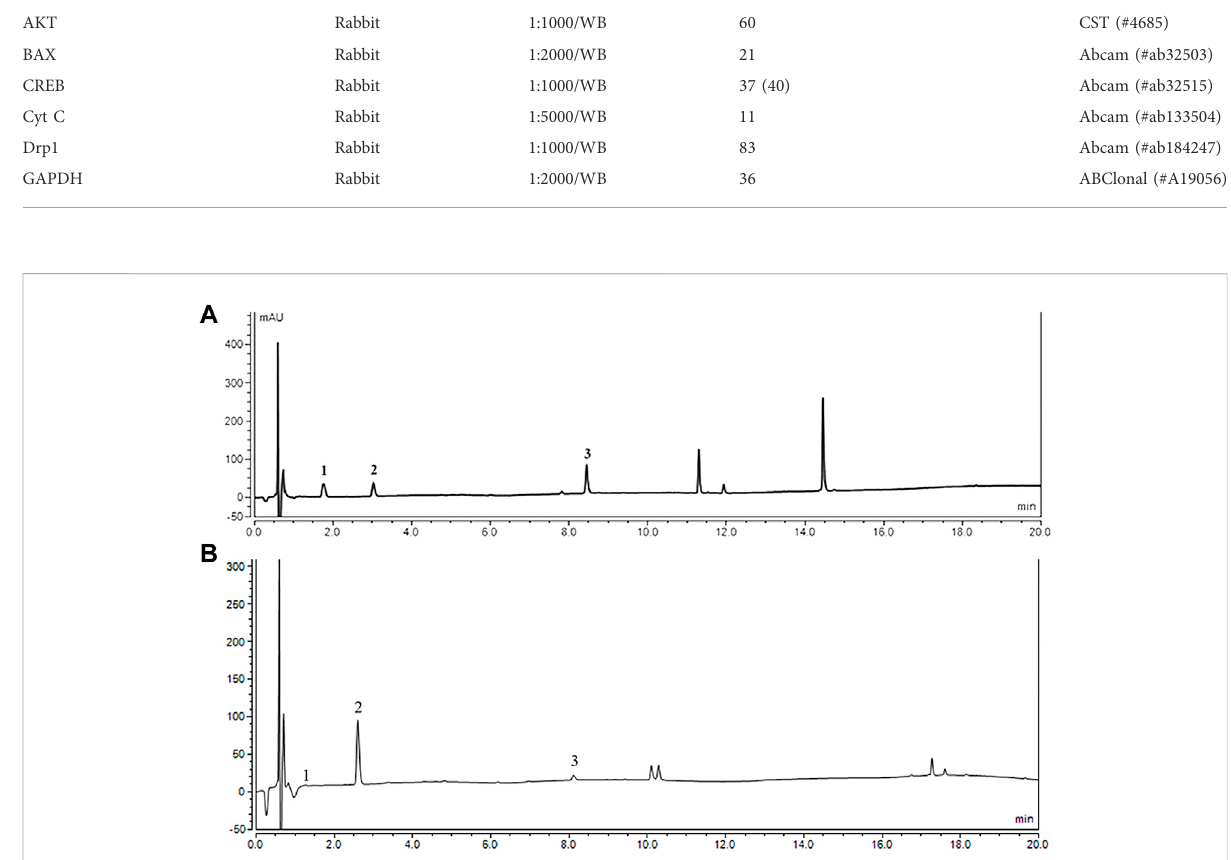
FIGURE 1 HPLC chromatograms of reference substance (A) and sample of FG. (B) (1) gastrodin; (2) p-hydroxybenzyl alcohol; and (3) Parishin